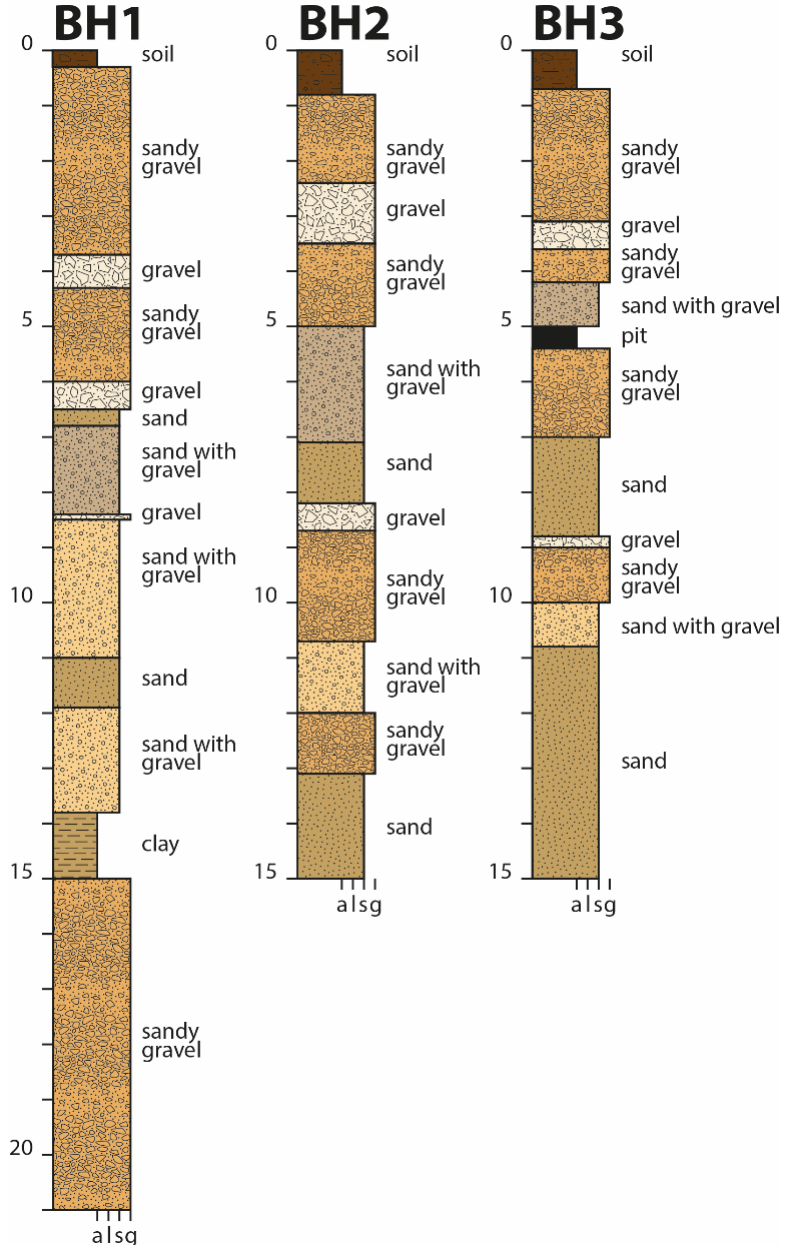
Figure 9. Borehole logs (the ground elevation was about 700 m a.s.l. for